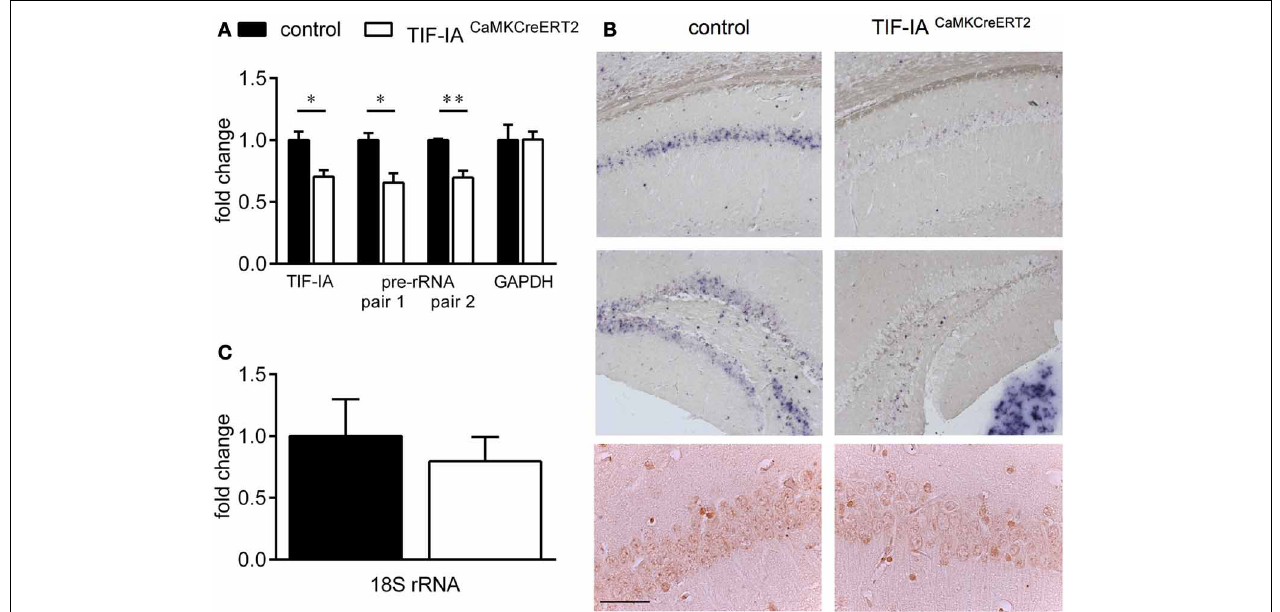
FIGURE 1 | Conditional ablation of TIF-IA reduces 47S pre-rRNA level in the hippocampus. (A) TIF-IA and GAPDH mRNA and pre-rRNA decrease by qPCR in the hippocampi of control and TIF-IA CaMKCreERT2 mutants 1 month after tamoxifen. (B) Upper panels: Representative images showing the specific effects of TIF-IA loss on pre-rRNA synthesis (blue staining) in CA1 and DG by in situ hybridization in coronal paraffin sections of control and